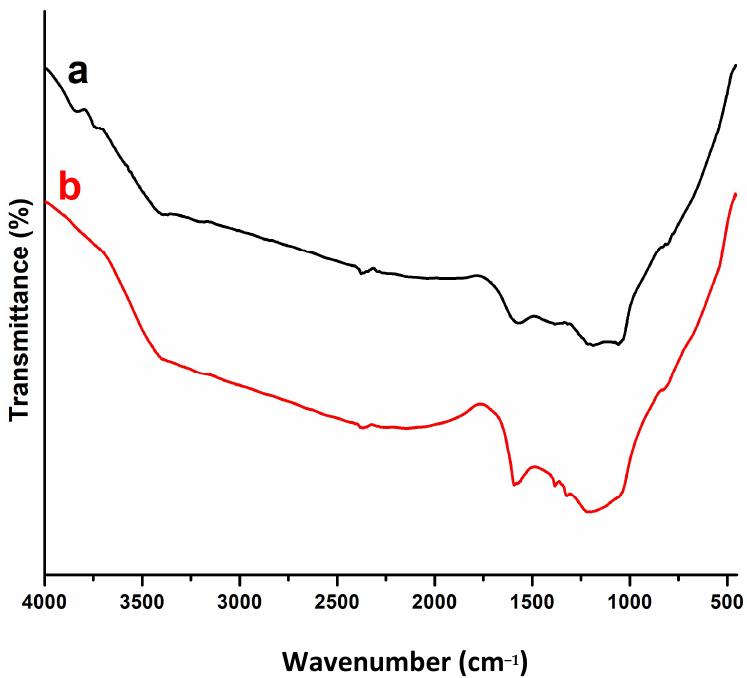
Figure 2. FTIR spectra of (a) BWAC and (b) MB-loaded BWAC.